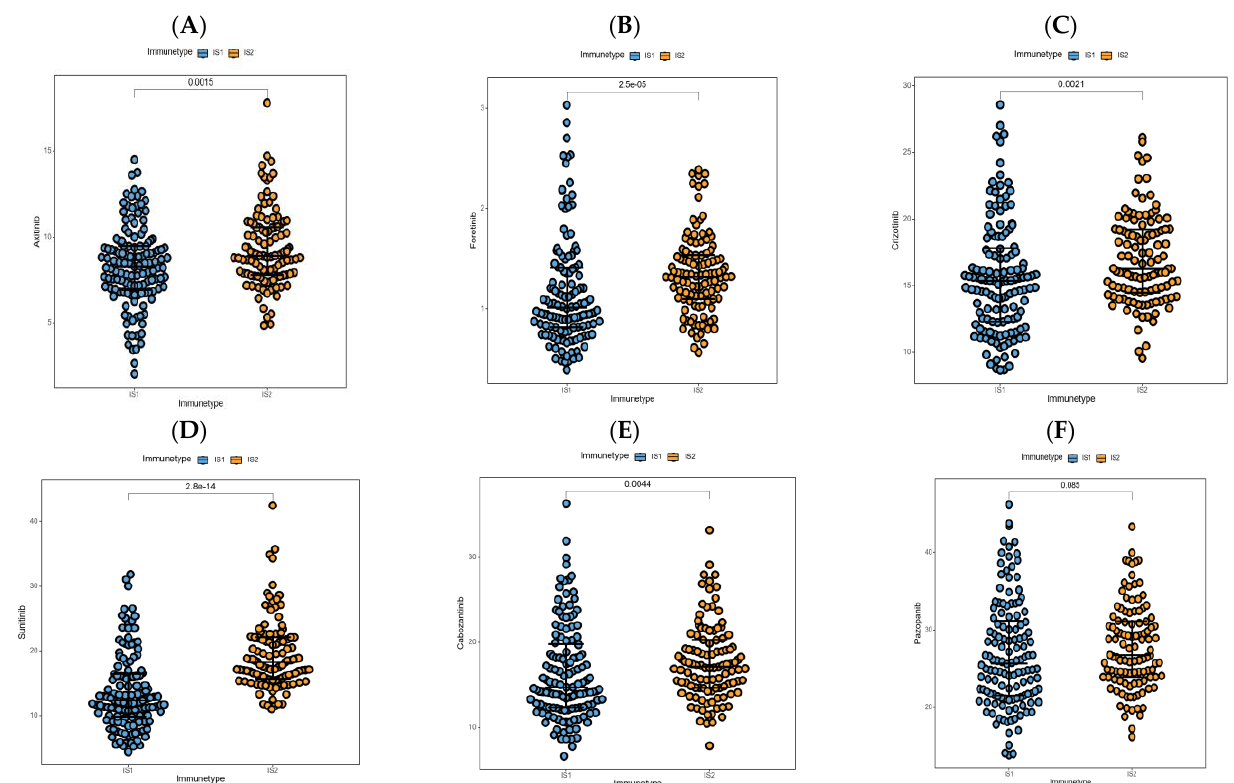
Figure 10. Anticancer drug analysis in PRCC patients with different immune types. ( A – F ) Half maximal inhibitory concentration (IC50) of multiple drugs in individuals with different immune types.